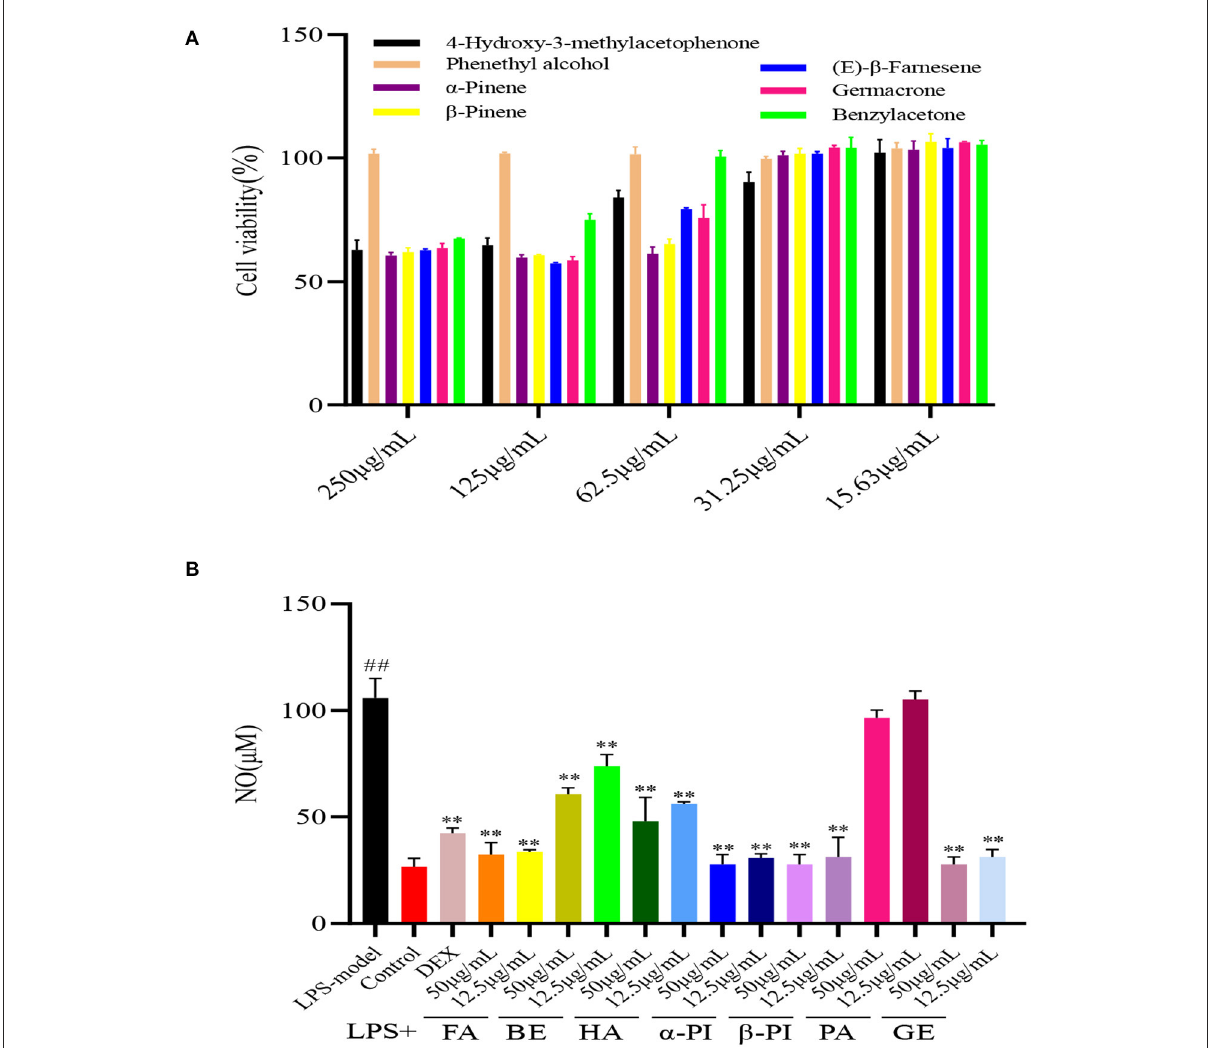
FIGURE3 The cell viability of seven components from four Rhododendrons species (A) and the inhibitory effect of these compounds on NO production in RAW264.7 cells induced by LPS (B) . (phenylethyl alcohol (PA), and 4-hydroxy-3-methylacetophenone (HA) from RPEO(essential of Rhododendrron przewalskii Maxim.), α -pinene ( α -PI) and β -pinene ( β -PI) from RAEO(essential oil of Rhododendron anthopogonoides Maxim.), β -farnesene (FA) and germacrone (GE) from RTEO(essential oil of Rhododendron thymifolium Maxim.), and benzylacetone (BE) from RCEO (essential oil of Rhododendron capitatum Maxim.) ( ## represent the significant difference between control group and model group, p < 0.01; ** for p < 0.01